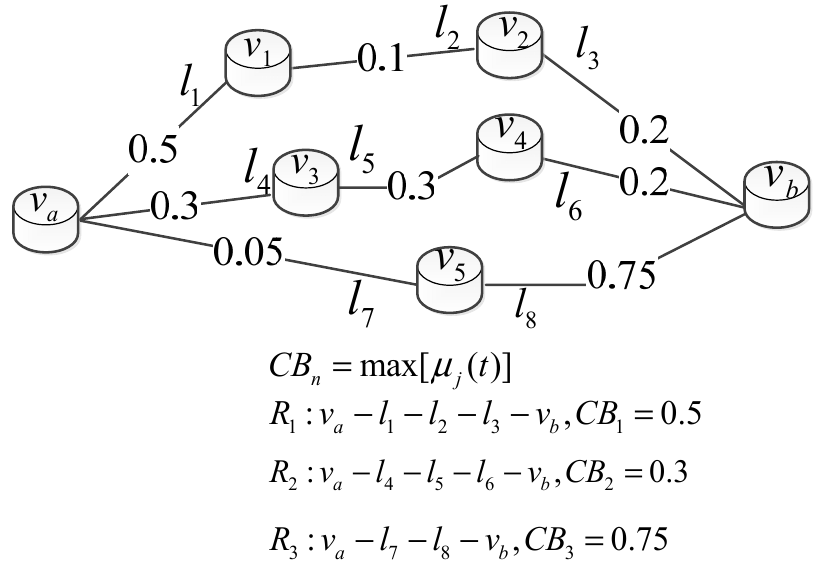
Figure 10. The path bandwidth occupancy rate at time t .